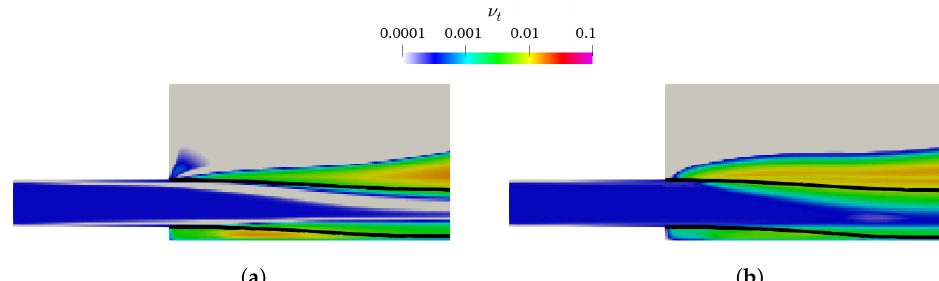
Figure 13. ν t at vertical central plane of the TPVoF model with R m = 20; interface ( α = 0.5, black line).